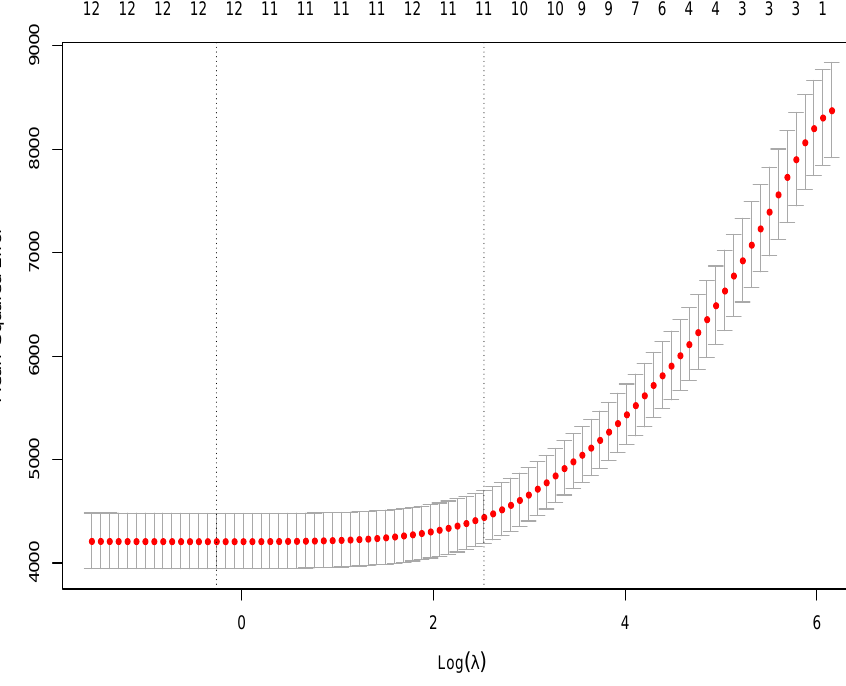
Figure 7. Variables selected using the elastic net.